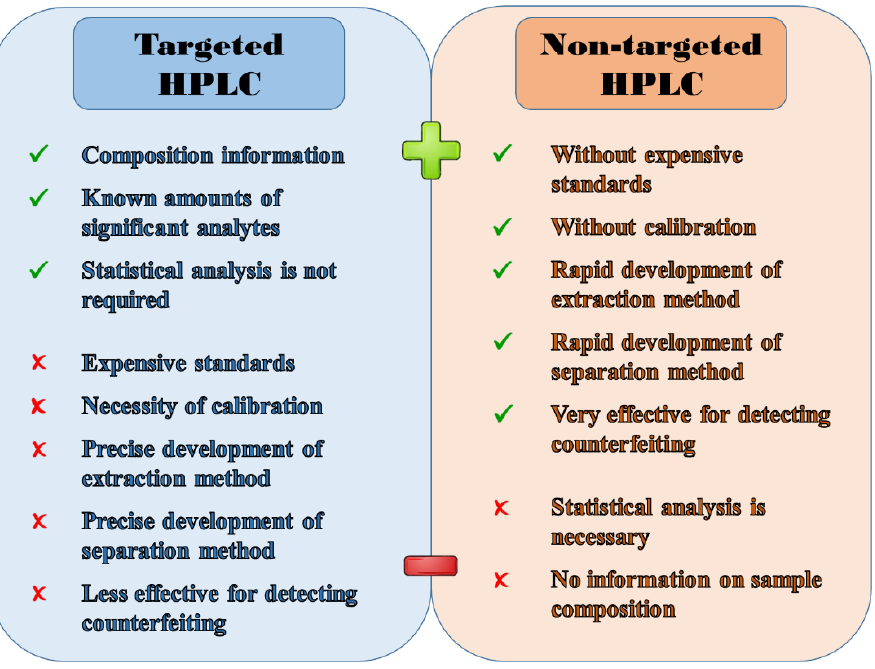
Figure 10. Principal benefits and drawbacks of targeted and non-targeted analysis.